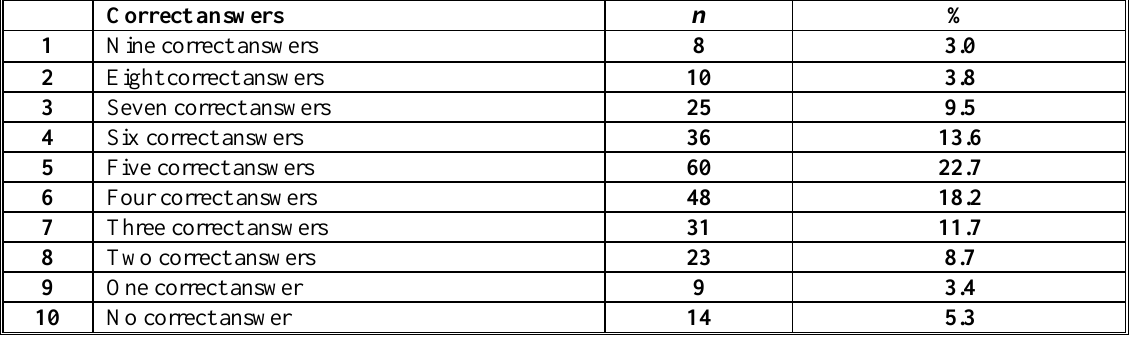
Table 4. Correlation between the score of adequate answer and pharmacist